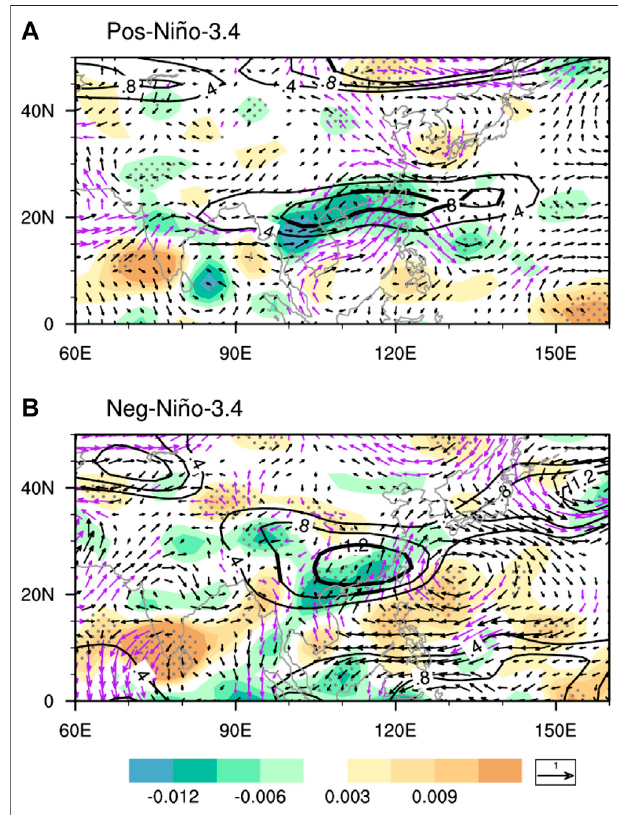
FIGURE 6 | Regression of summer 500-hPa vertical velocity (shading, Pa s − 1 ), 200-hPa zonal winds (black contours, m/s), and 850-hPa winds (arrows, m/s) onto summer HK Prec for years with (A) a positive Niño-3.4 index and (B) a negative Niño-3.4 index. Stippling, thick black contours, and purple arrows are signi fi cant at the 90% con fi dence